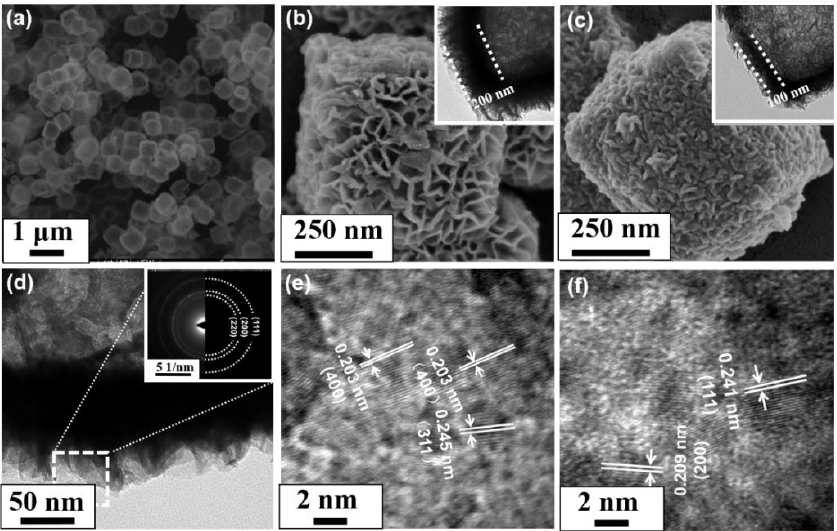
Figure 4. ( a ) TEM images of Ni-Co hydroxide precursor and ( b , c ) SEM of prepared Ni-Co